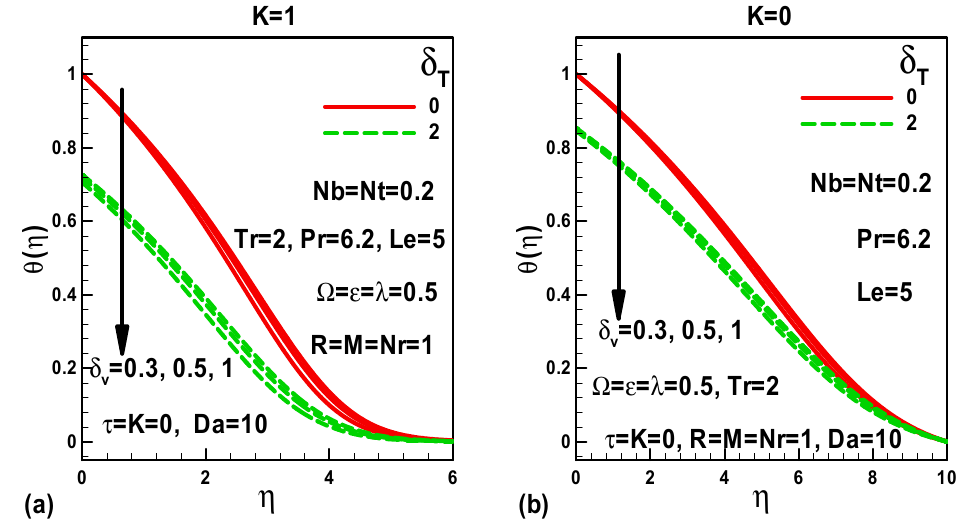
Figure 6. Effects of slip parameters on dimensionless temperature ( a ) with pressure gradient and ( b ) without pressure gradient.